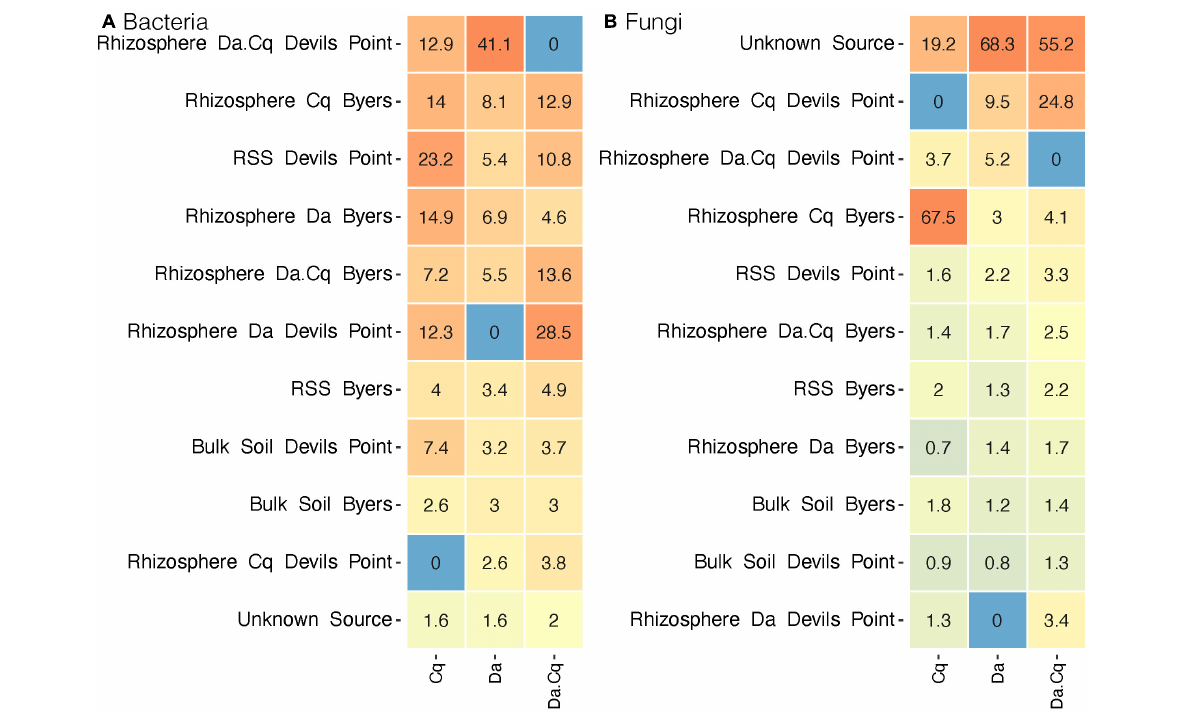
to the fungal community assembly process in the